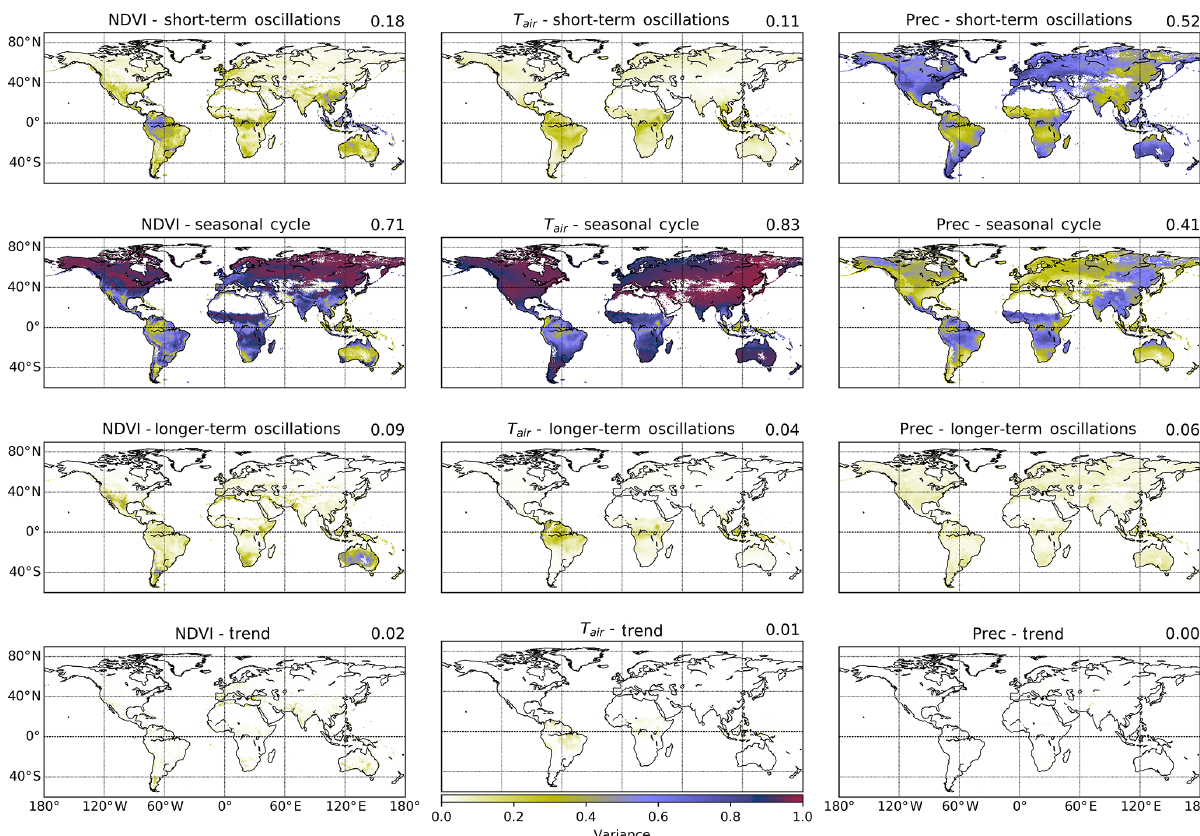
Figure 1. Global distribution of timescale-specific variance (relative spectral powers) of the normalized difference vegetation index (NDVI), air temperature ( T air ), and precipitation (Prec). Normalized time series of NDVI, T air , and Prec (columns) were decomposed by fast Fourier transformation and reconstructed into short-term (intra-annual), seasonal (annual), and longer-term (interannual) components (rows). The relative contribution of each scale-specific signal to overall variance was determined at each grid cell. Globally, most of the variance of NDVI and T air is contained in the seasonal component (red colors), while Prec shows a high contribution of variance from the short-term component. The semiannual cycle is included in the seasonal band. Upper-right-corner values show the percentage of overall variance explained by each